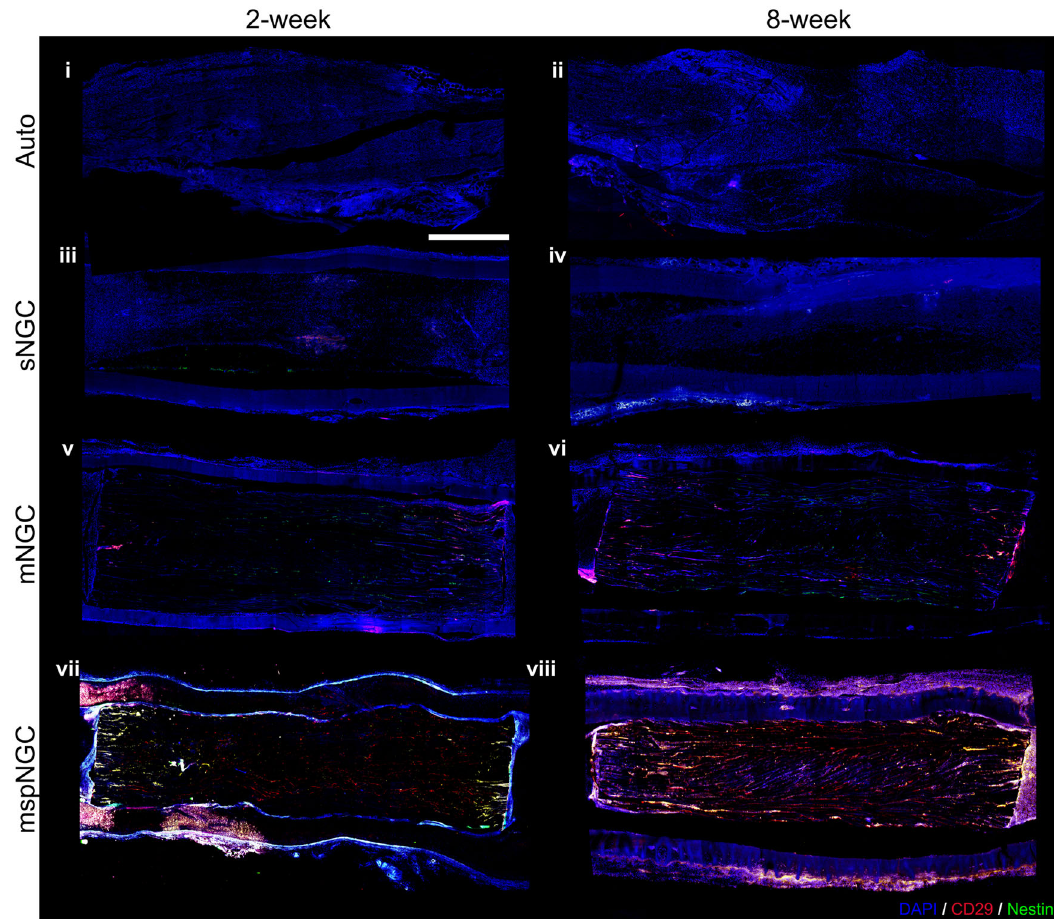
Fig. 4 Recruitment of neural stem cells into NGC channels. Fluorescence micrographs of longitudinal sections of implant groups, showing neural stem/progenitor cell recruitment along the channels in i , ii the autograft, iii , iv sNGC, v , vi mNGC, and vii , viii mspNGC. Green, red, and blue represent the expressions of Nestin, CD29, and DAPI, respectively. Scale bar indicates 1